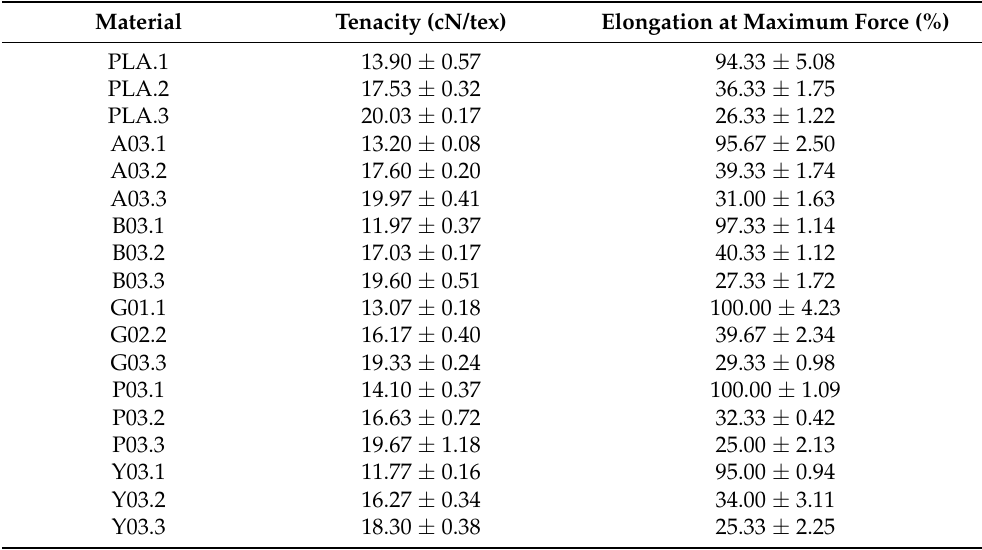
Table 3. Tenacity and elongation of PLA and dyed yarns containing 0.3% ( w / w ) of each colorant with standard deviations (SD). Material Tenacity